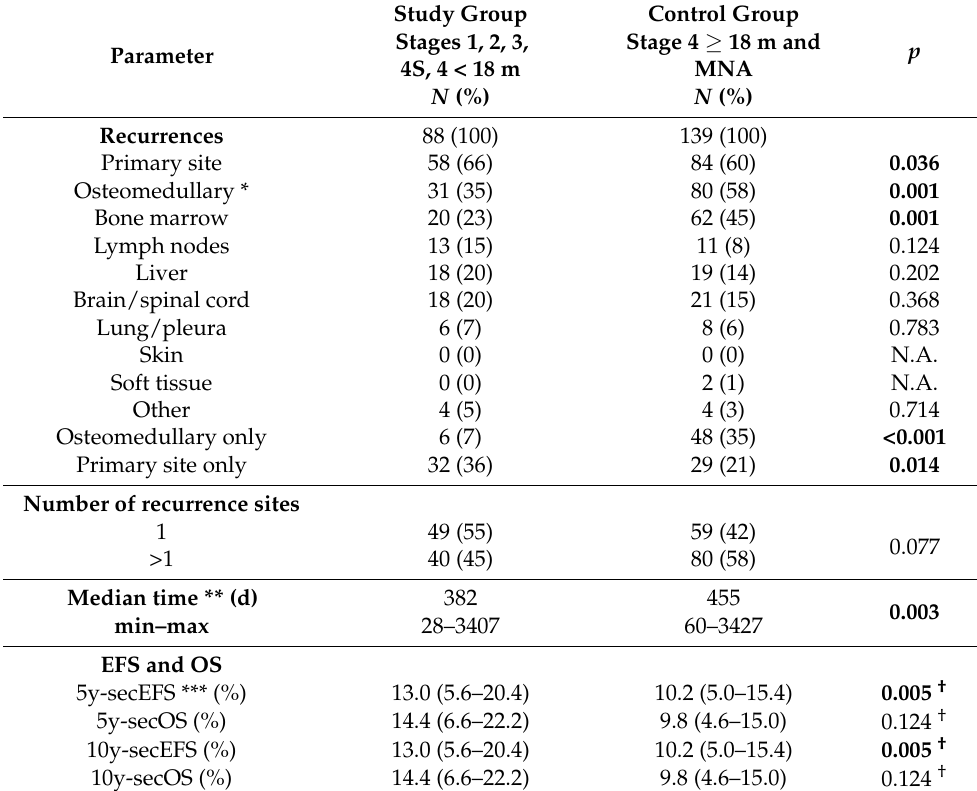
Table 4. Recurrence patterns of study and control group